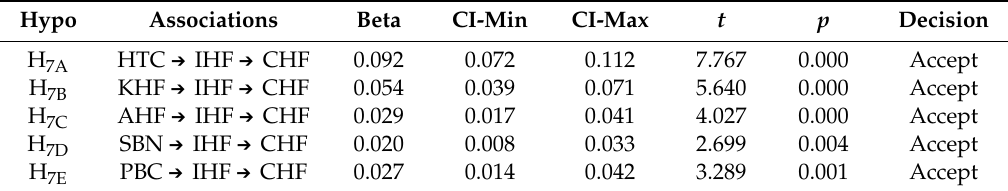
Table 6. Mediating e ff ects.